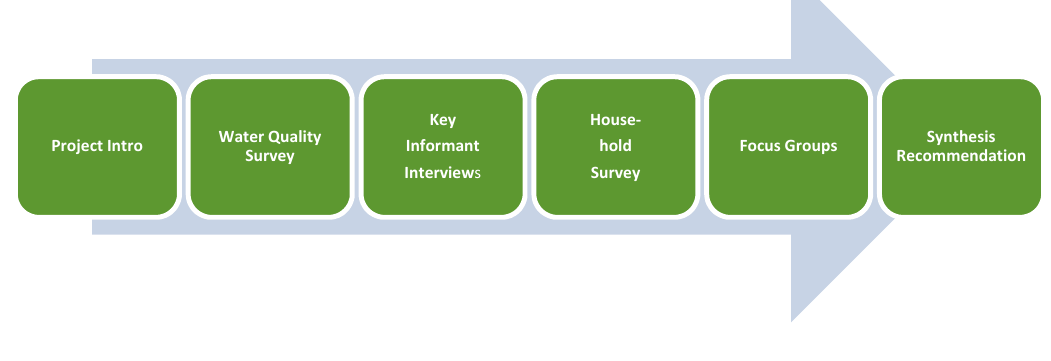
Figure 2. Summary of our assessment